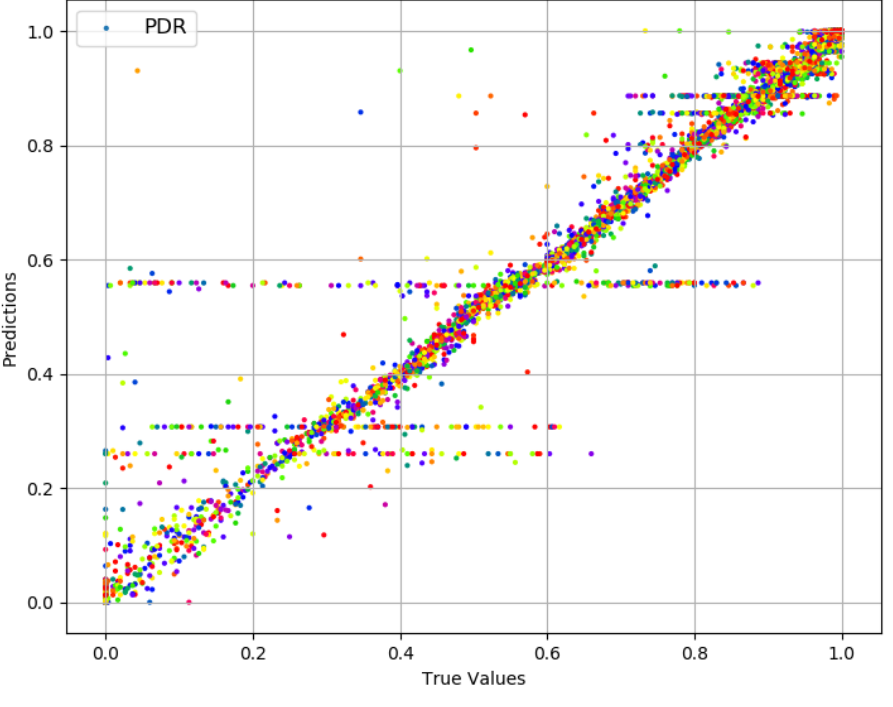
Figure 4. Actual values vs. predictions for PDR .